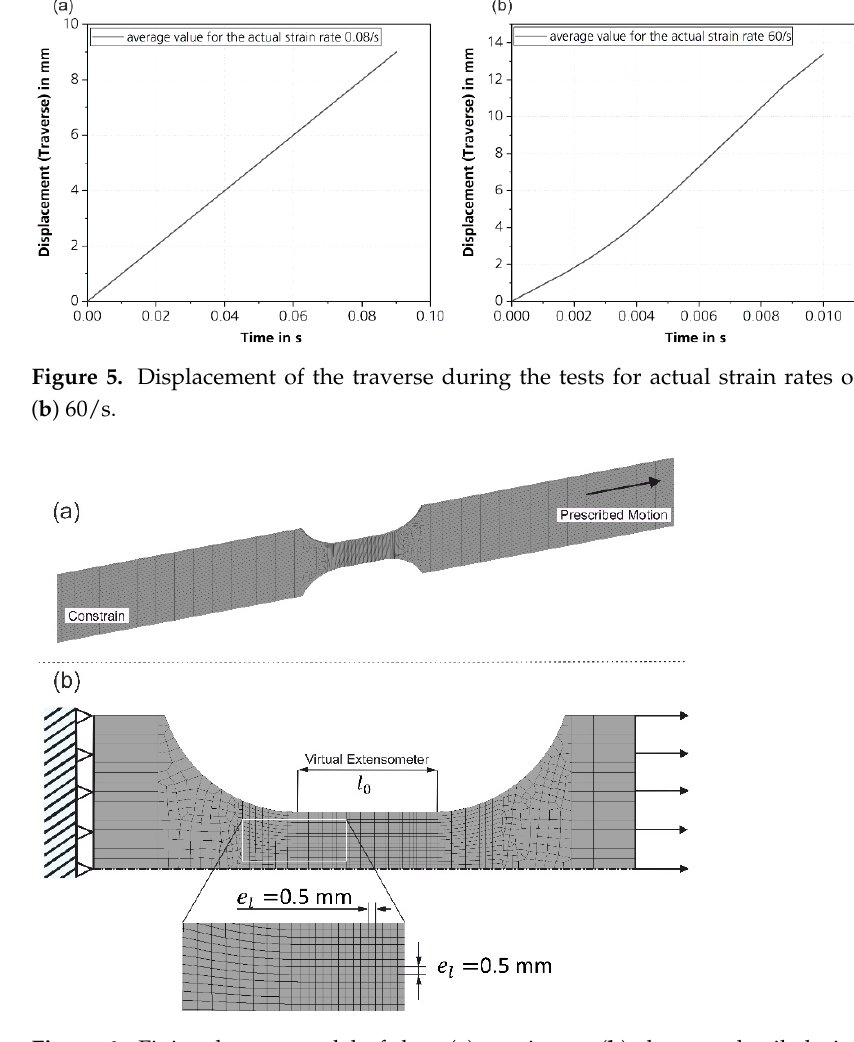
Figure 6. Finite element model of the—( a ) specimen. ( b ) shows a detailed view of the virtual extensometer and the used element size.